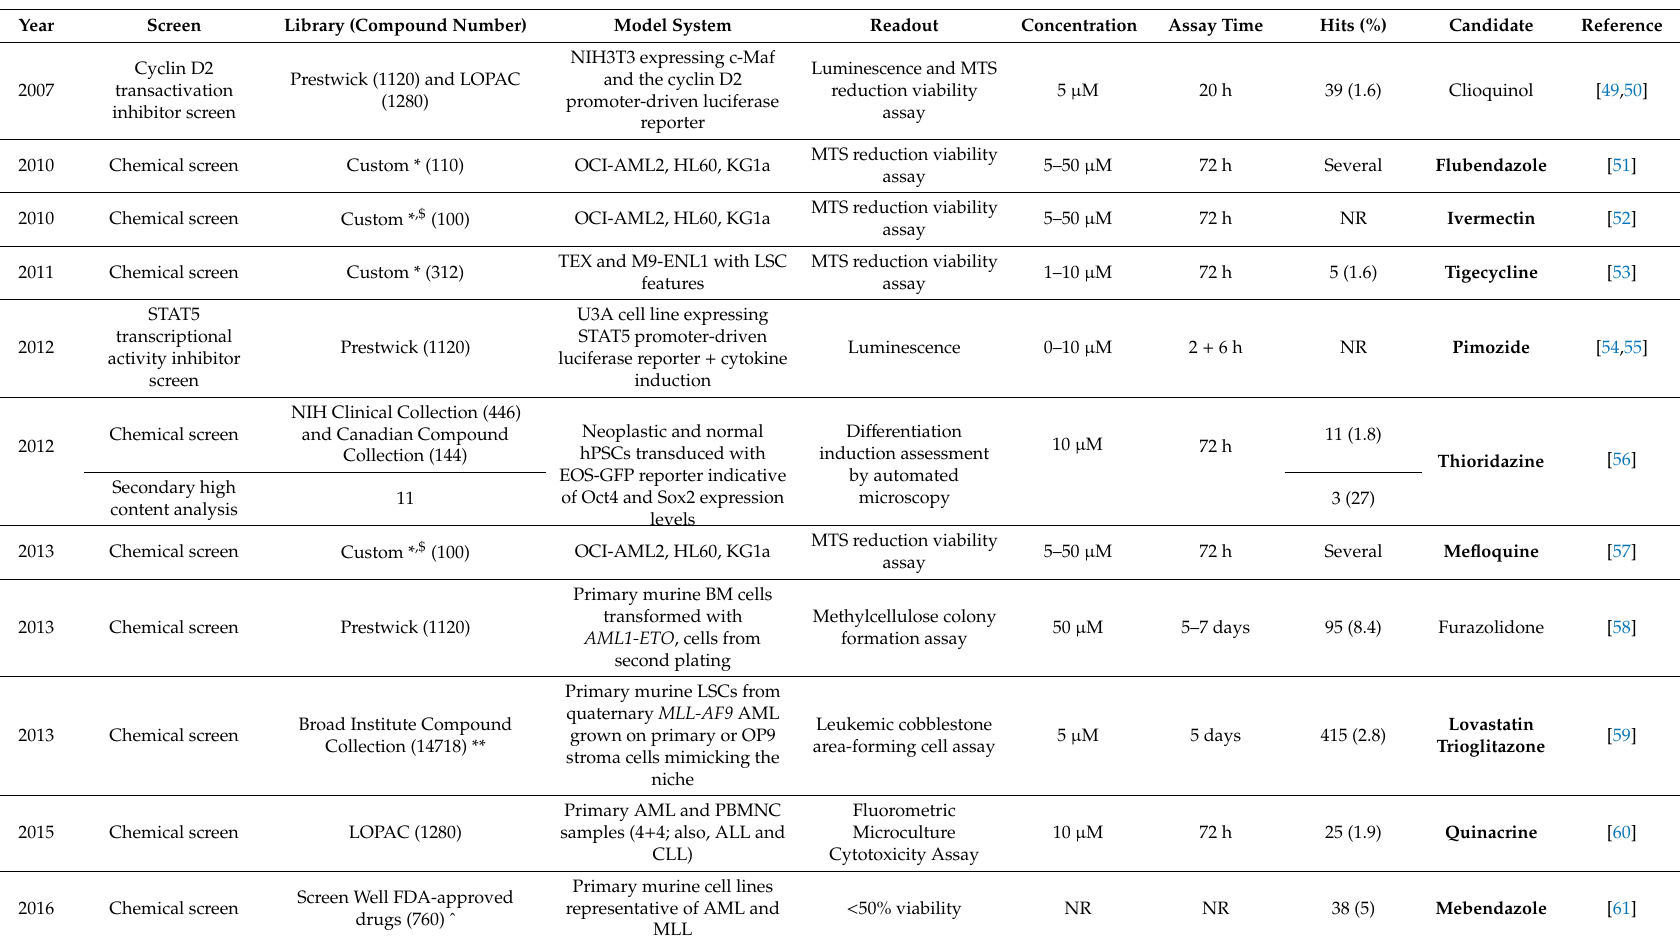
Table 1. Screening projects to identify candidate compounds for repurposing in